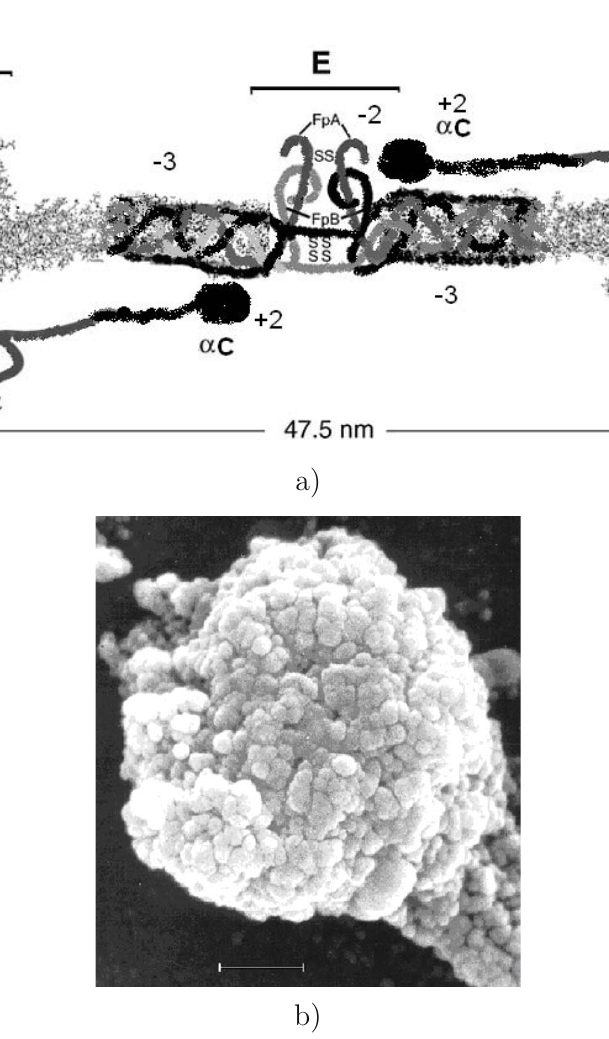
Fig. 1 (a) Model of HPF molecule (size 9 × 47.5 × 6 nm) with charges of fragments; and (b) SEM image of agglomerate ( ∼ 5 μ m in diameter) of aggregates (50-500 nm) of